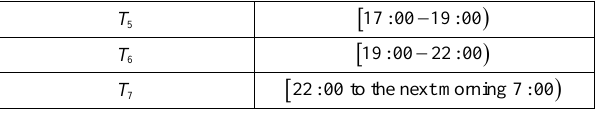
Table 3. Bicycle Station State Change Cycle (24